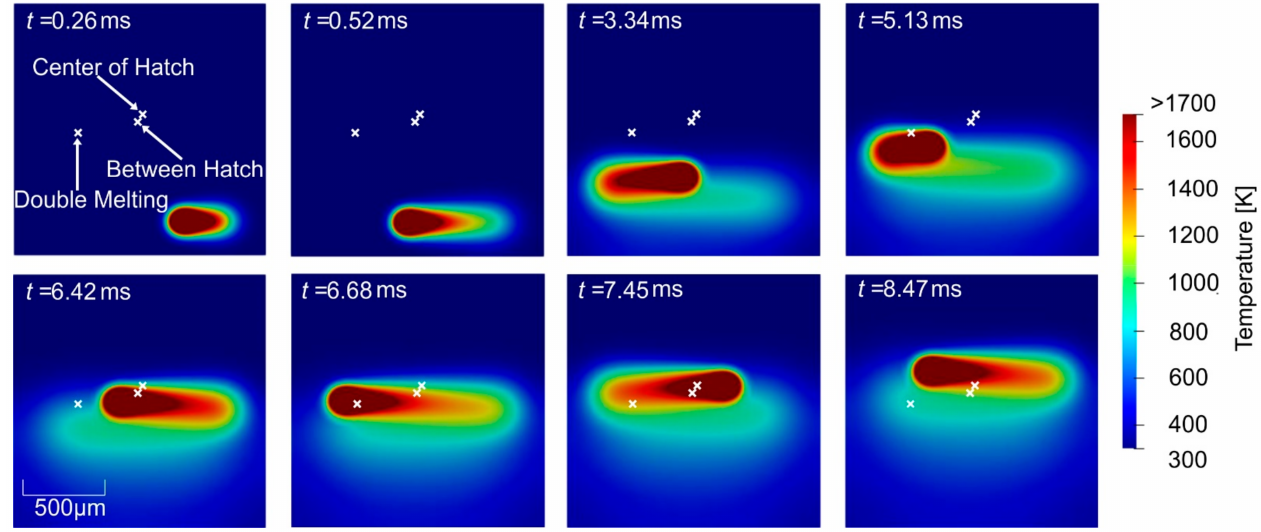
Figure 3. Heat map of the thermal history in stainless steel 316L manufactured by laser powder bed fusion predicted by the model developed by Wolfer et al. The white X’s mark the location of the temperature histories used as inputs to the CALPHAD-based ICME (CALPHAD: Calculation of Phase Diagrams, ICME: Integrated Computational Materials Engineering)